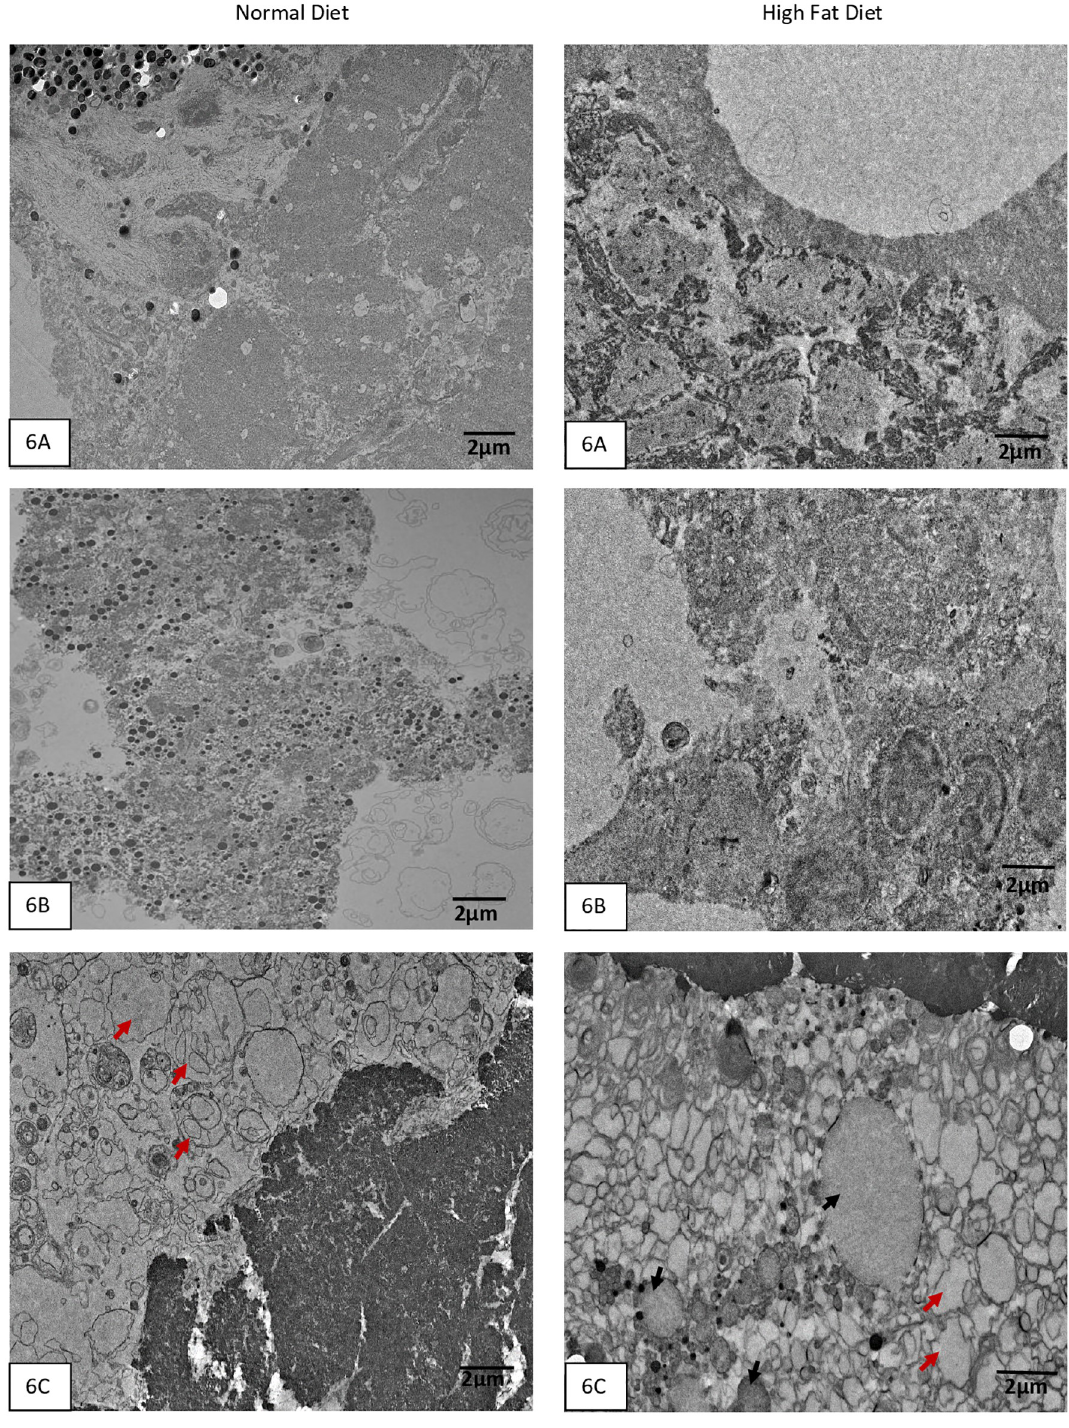
Fig 6. A-C . Transmission Electron Microscopy of zebrafish liver sections at medium magnification show the presence of neutral fat with HFD in normal Tab-5 Fig 6A, transgenic with normal GCKR Fig 6B, and transgenic with mutant GCKR Fig 6C. Neutral fat appears as small round vesicles with no structure. There is abnormal fat accumulation in the transgenic mutant fish with HFD (Fig 6C). Black arrows point to round vesicle like structures with empty content which are fat droplets. The red arrows point to two huge abnormal structures which appear like fusion of large neutral fat vesicles in the transgenic mutant with HFD. However, the transgenic mutant with normal diet shows abnormal structures with possible accumulation of phospholipids (red arrows) in hepatic cells suggesting abnormal metabolic